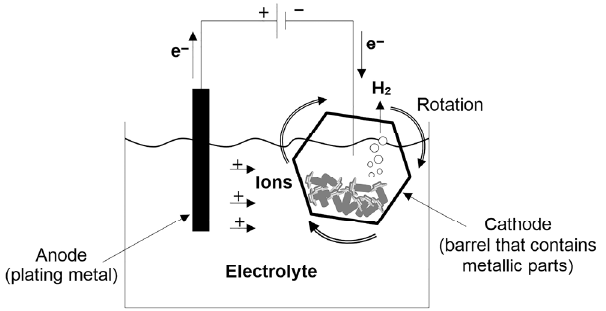
Fig. 1 Schematic of a simple barrel plating